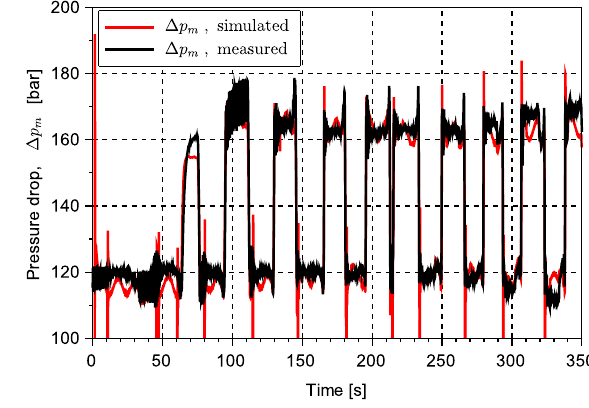
Figure 18: Comparison of measured versus simulated pressure drop across the motors for Test 3.